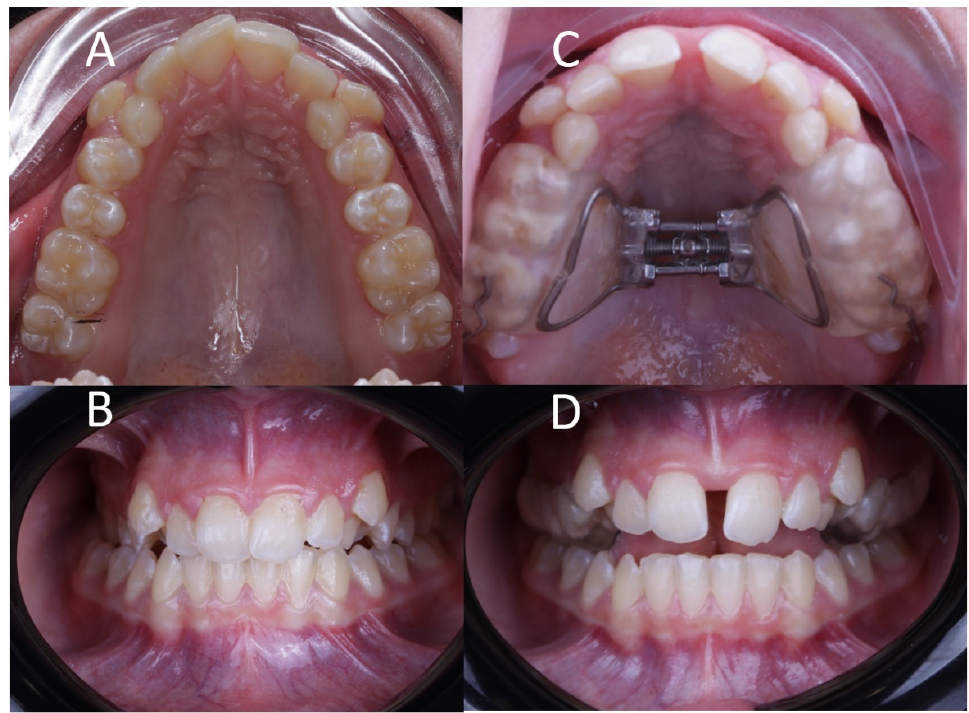
Figure 1. ( A ) Preoperative occlusal and ( B ) frontal view, and ( C ) postoperative occlusal and ( D ) frontal view after RME treatment with McNamara appliance.